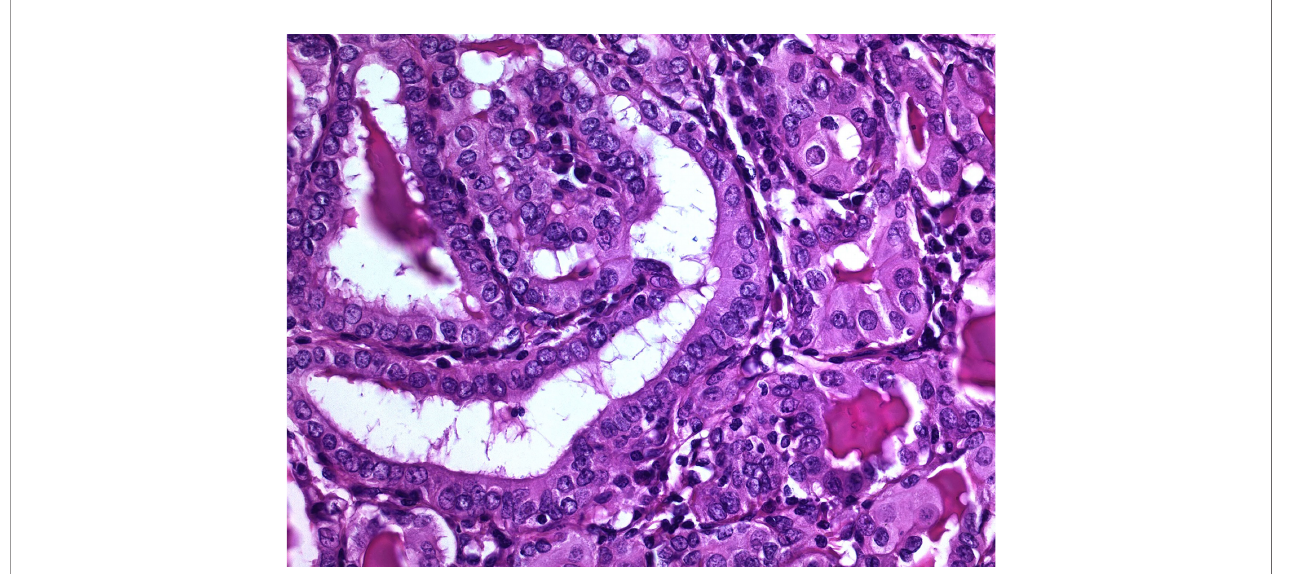
FIGURE 1 | Non-syndromic familial papillary thyroid carcinoma. This tumor occurred in a patient with two fi rst-degree relatives having non-medullary thyroid carcinoma, in the absence of a history of ionizing radiation exposure (hematoxylin-eosin, 400X). Typically, these familial thyroid tumors are not morphologically different from their sporadic